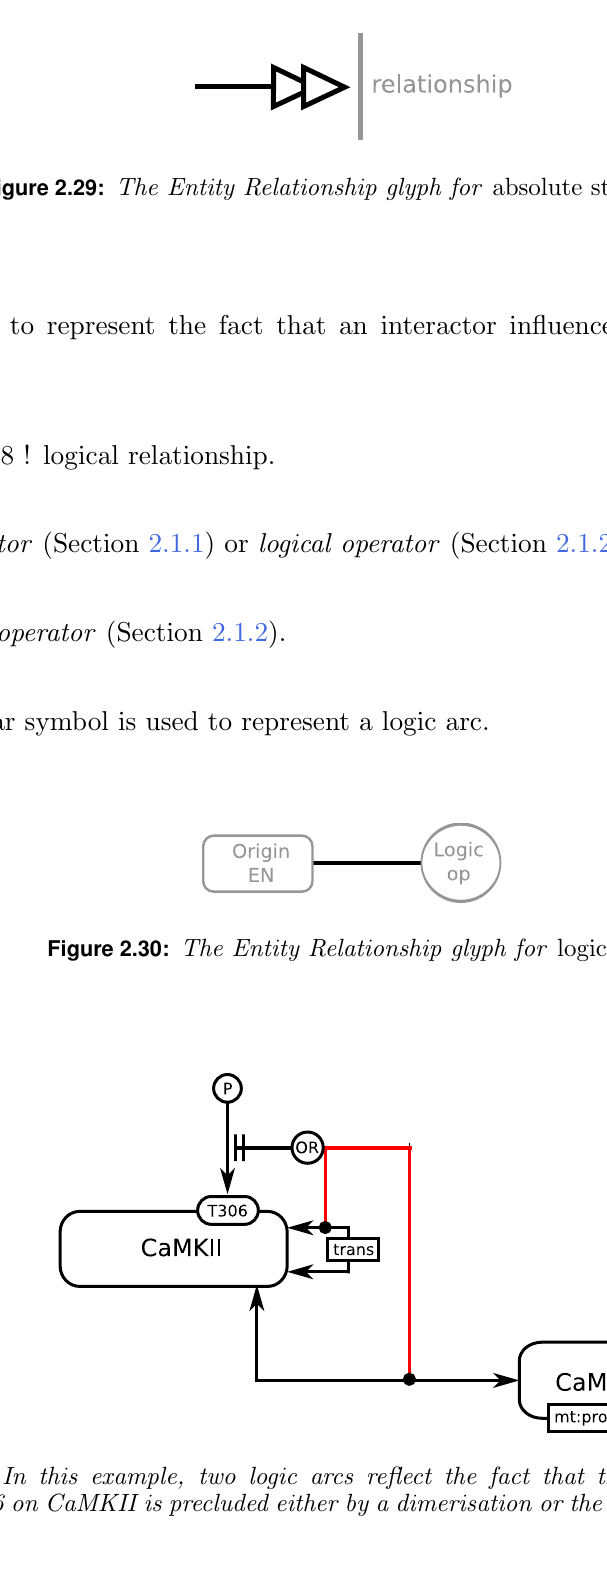
Figure 2.29: The Entity Relationship glyph for absolute stimulation .